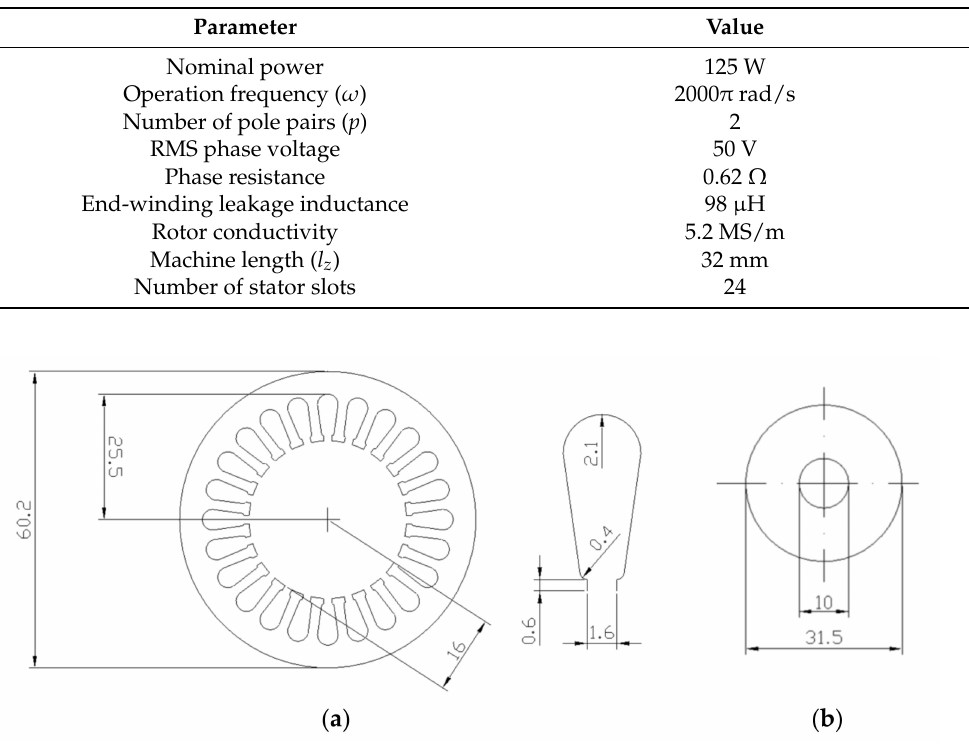
Table 1. Basic specifications of tested induction motor [31].